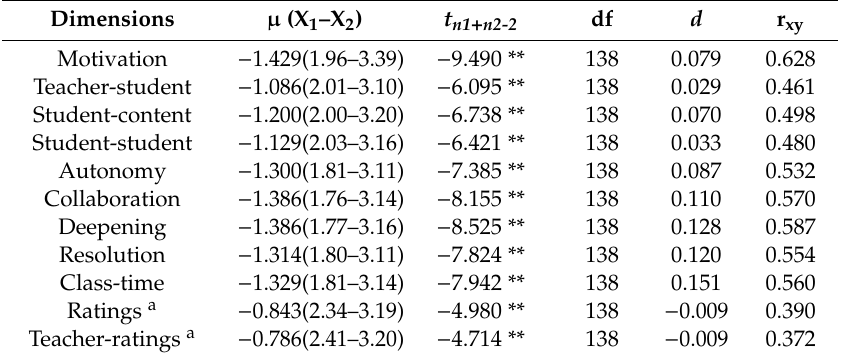
Table 4. Study of the value of independence between the control group and experimental group.